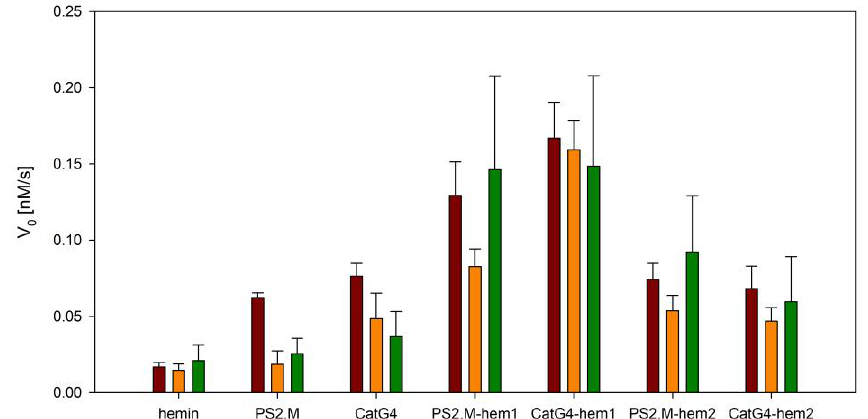
Figure 4. Peroxidase activity of the studied systems in the oxidation of Amplex Red. The colors of the bars represent various conditions: the presence of potassium cations (brown) and sodium cations (orange), or the absence of cations (green). Conditions: 0.05 µM DNA, 0.05 µM hemin (if present), 100 mM KCl or NaCl, 10 mM Tris-HCl (pH 8.0), 1 µM Amplex Red, and 10 µM H 2 O 2 . The values were averaged across three experiments.